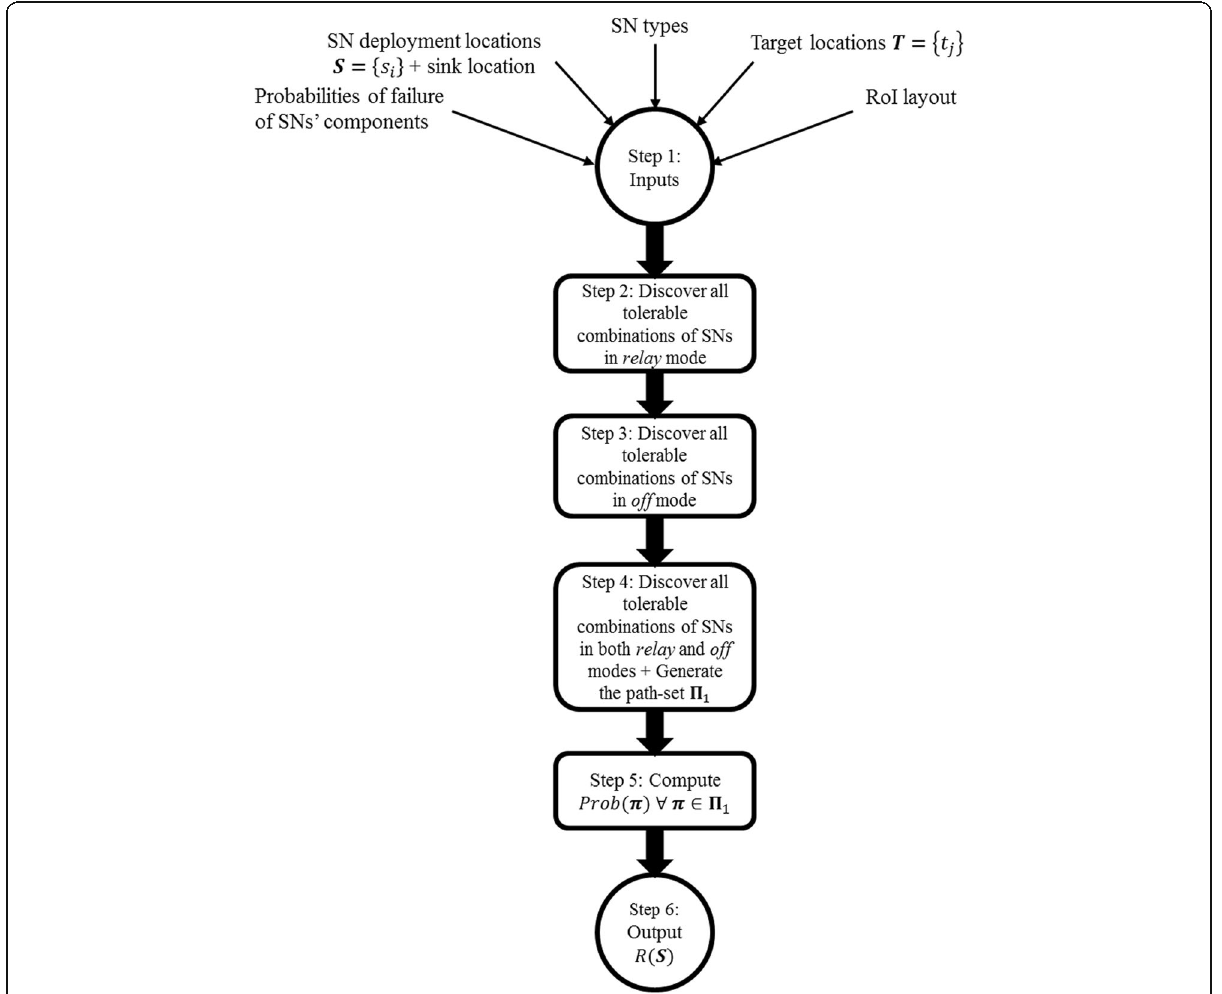
Fig. 4 The structure of the proposed algorithm for evaluating the WSN reliability R ( S